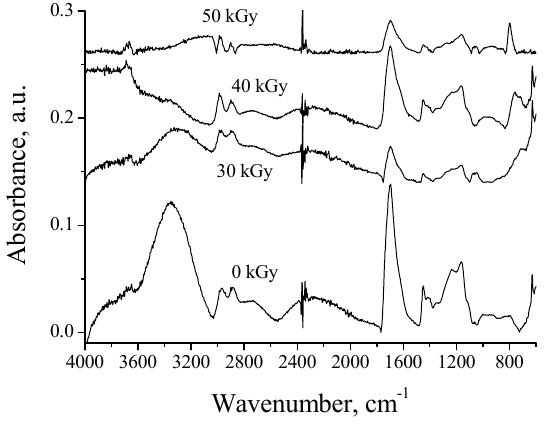
Figure 3. FTIR spectra for poly(acrylic acid) ( PAA) before and after irradiation.